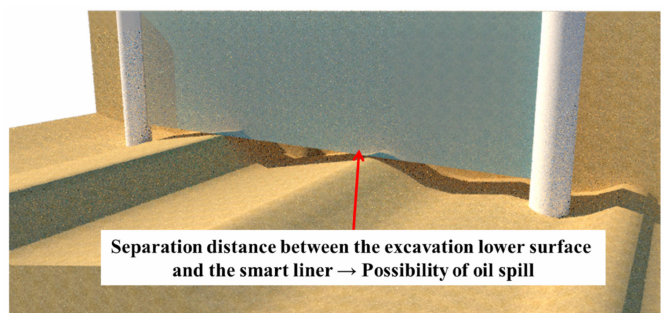
Figure 8. Problem when the leveling of the excavation lower surface is not performed.